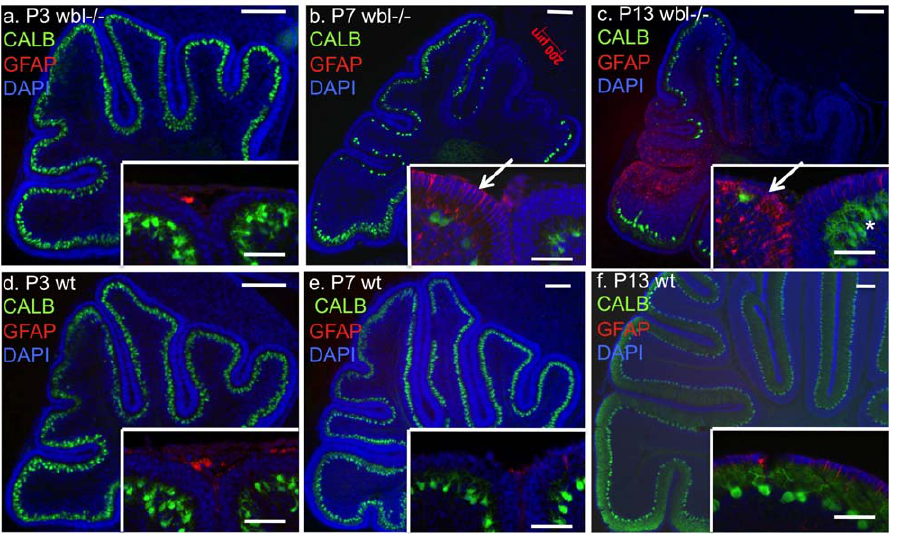
Figure 2. Rapid early onset Purkinje cell loss in Inpp4a wbl mutants. Sagittal sections at the midline of the cerebellum from postnatal day 3, 7 and 13 mutants (panels a,b,c) and matched wild-type littermate controls (panels d, e, f). All sections were matched using the superior cerebellar peduncle. Purkinje cells are labeled with anti-calbindin (green), reactive gliosis is indicated by anti-GFAP antibody (red) and sections are counterstained with DAPI (blue) (scale bar=200 microns). High GFAP staining (red) indicative of reactive gliosis is seen restricted to certain lobes. Insets show neighboring folia with different degrees of gliosis and cell loss (arrows, scale bar=50 microns) and surviving Purkinje cells in the mutant, which appear normal (asterisk).